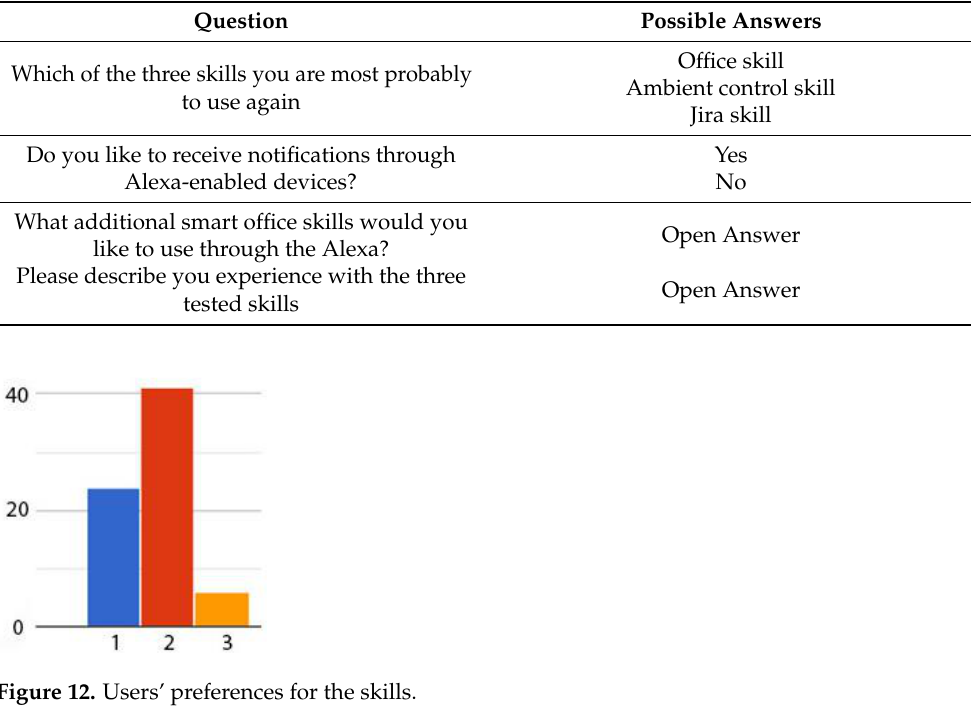
Table 5. Polarity results for the last question of the survey, using different tools.